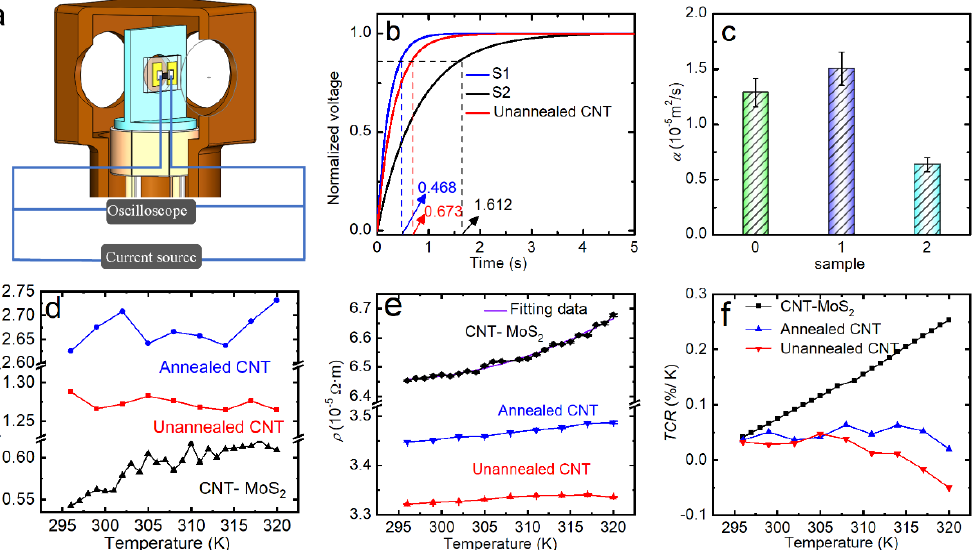
Figure 3. ( a ) Schematic of the experimental setup used for measuring the α and electrical resistance values from 296 K to 320 K. ( b ) The normalized voltage curves of TET signals and the characteristic times of the unannealed CNT network and the CNT–MoS 2 composite network with low and high MoS 2 composite density, respectively. ( c ) A comparison of the measured α value at RT against the MoS 2 composite density. ( d ) The measured α value. The measurement uncertainty of α based on the TET technique is ±10%, which is omitted in the figure for better comparison. ( e ) A comparison of the resistivity and ( f ) TCR values of the samples at different temperatures (296 K–320 K).